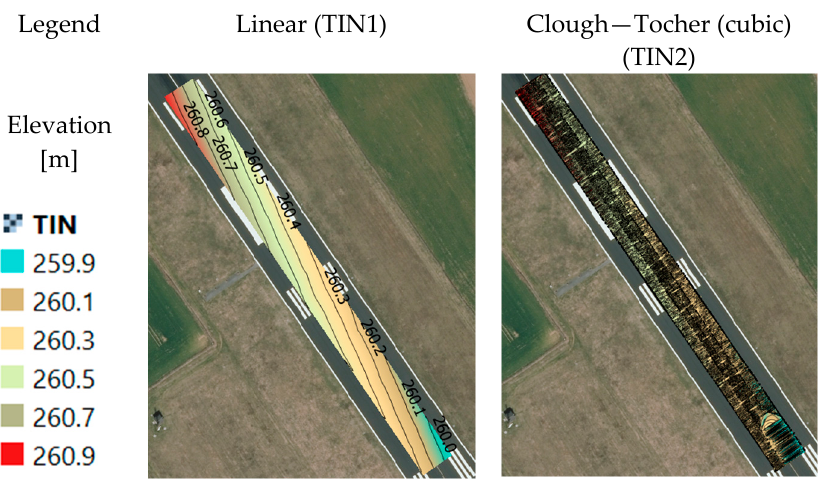
Figure 6. Results of TIN interpolation. Table 3. Results of TIN interpolation.